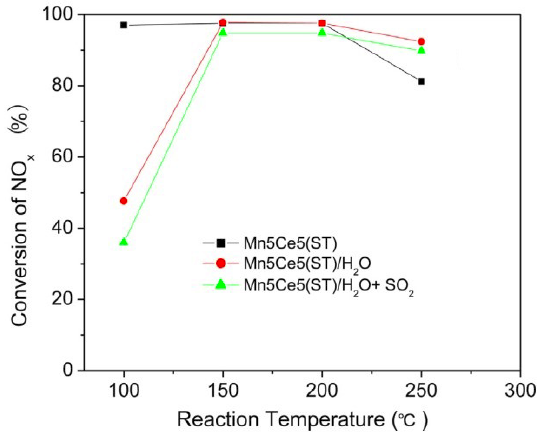
Figure 5. Catalytic performance of Mn 5 Ce 5 (ST) catalysts in the presence of H 2 O and SO 2 (Reaction conditions: NO = 500 ppm, NH 3 = 500 ppm, O 2 = 5%, H 2 O = 5%, SO 2 = 50 ppm, GHSV = 64,000 h − 1 ). (Reproduced with permission from Reference [25], Copyright 2013, Elsevier.).